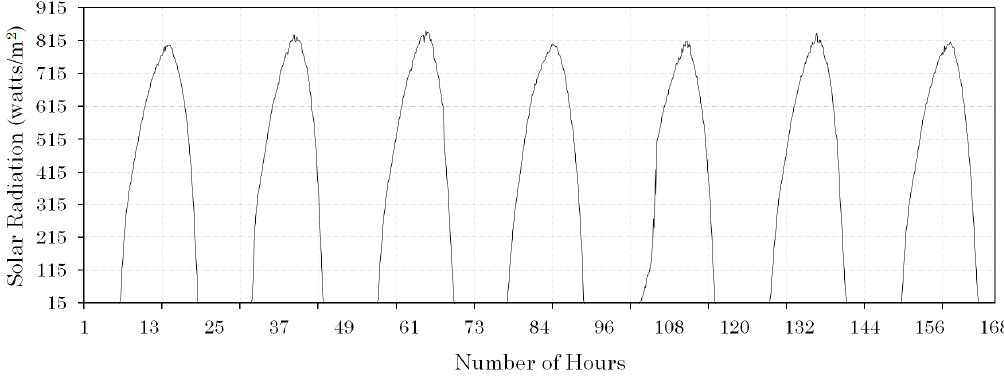
Figure 5. The verified solar irradiance from 23 to 29 July for the city of Évora.